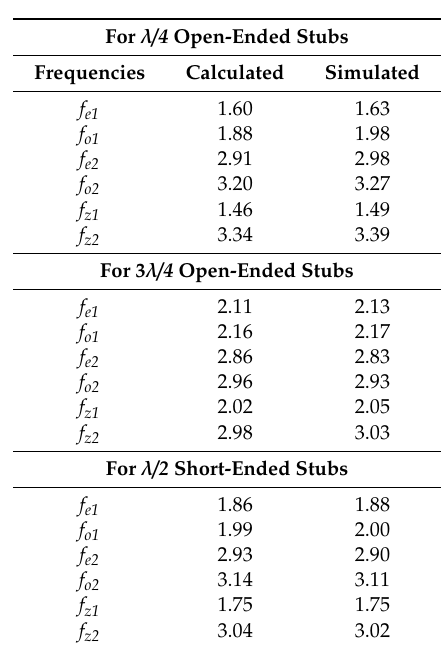
Figure 2. ( a ) Even- and odd-mode frequencies vs length ratio ‘ d ’, ( b ) TZ’s frequencies vs length ratio ‘ d ’. Table 1. Calculated and simulated values of resonant frequencies for different cases of stub lengths (Units: GHz).